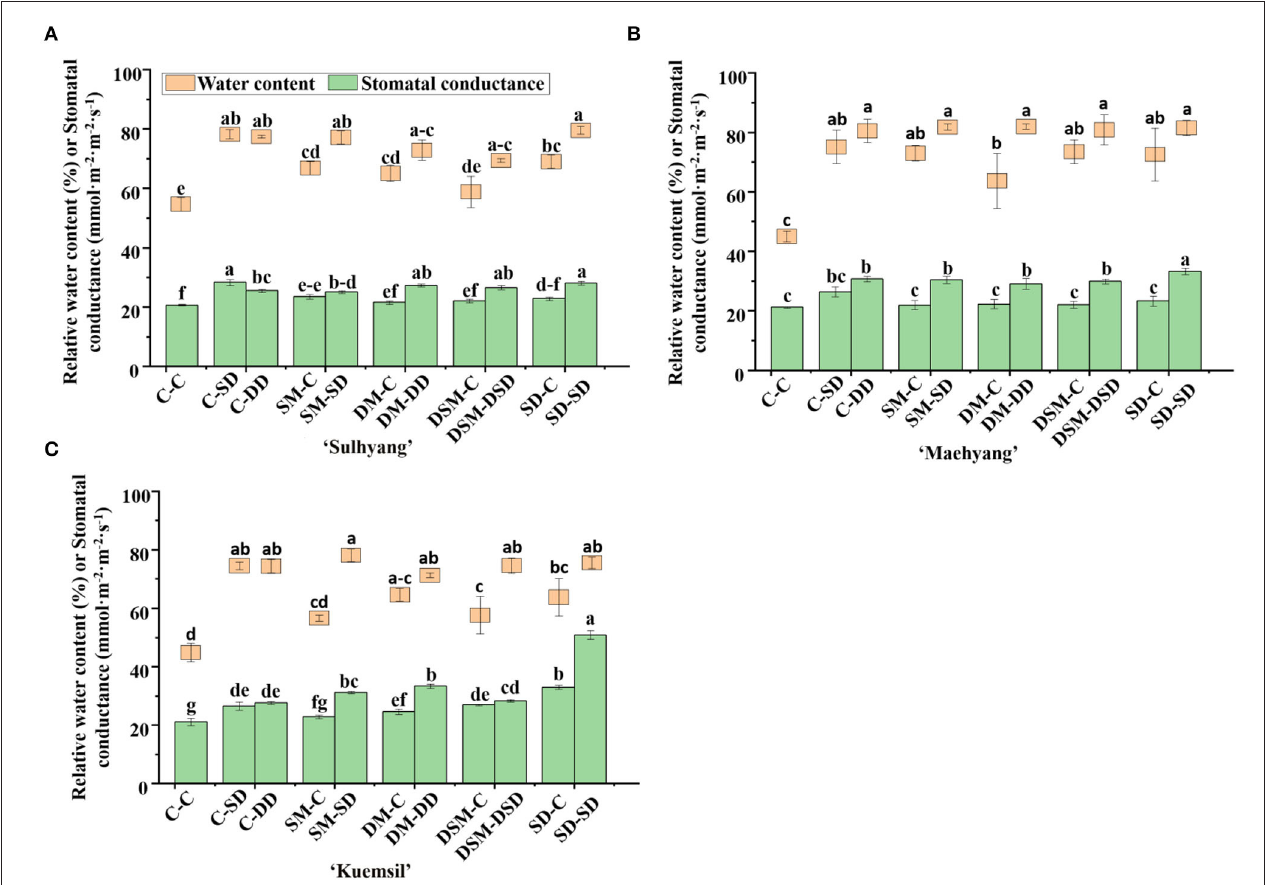
Figure 1 for descriptions of treatment